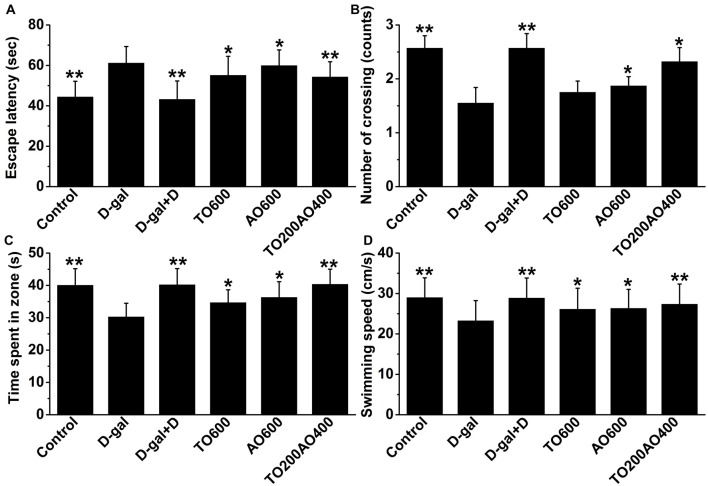
The effects of oil treatment on memory and spatial learning in D-gal-treated female mice. (A) Escape latency to the hidden platform on the 5th day. (B) The exact number of platform crossings on the 5th day. (C) A comparison of time spent in the target quadrant on the 5th day. (D) The swimming speeds on the 5th day. The data are shown as the mean ± SEM, n = 12 per group. *P < 0.05, **P < 0.01 vs. D-gal group.